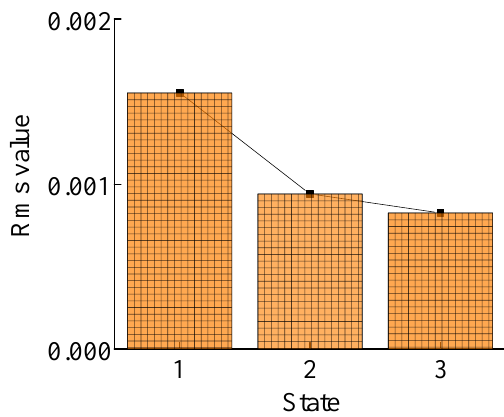
Figure 27. Root-mean-square values in different states.